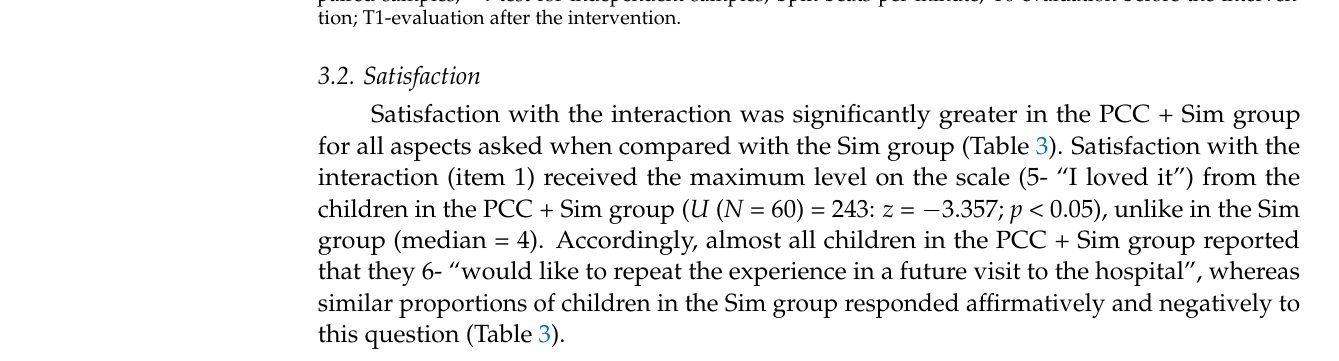
Table 3. Children’s satisfaction with the interaction in the simulation group (without the PCC model) and in the PCC + Sim